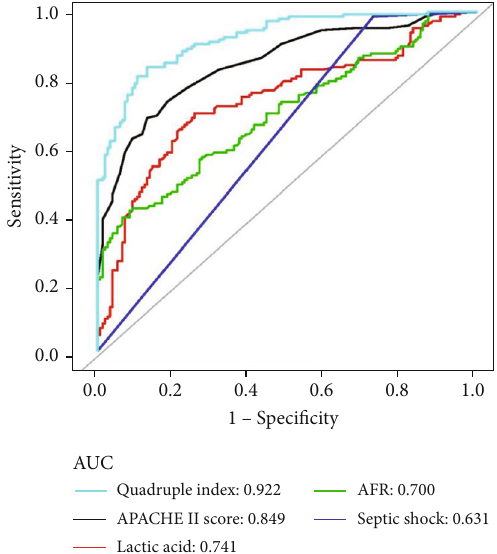
Figure 3: The ROC curve analysis of APACHE II score, lactic acid, septic shock, AFR, and quadruple index for the prognostic value of 28-day mortality in patients with sepsis. ROC: receiver operating characteristic; AUC: area under the curve; APACHE II: Acute Physiology and Chronic Health Evaluation; AFR: albumin-to- fi brinogen ratio; quadruple index includes APACHE II score, lactic acid, septic shock, and